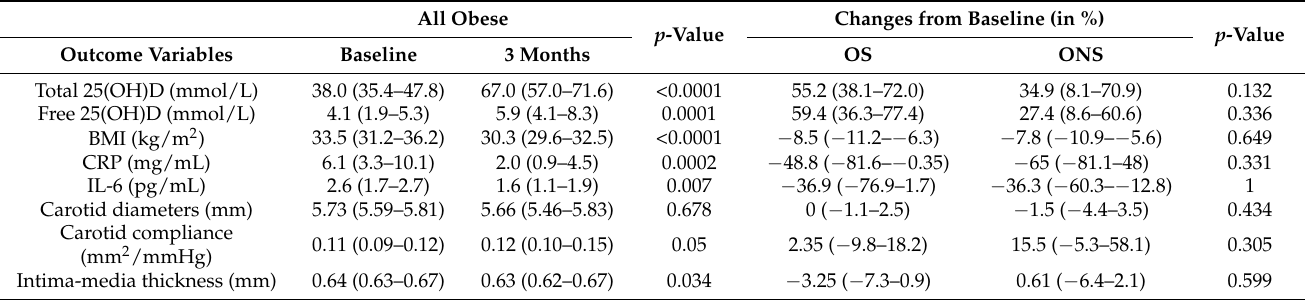
Table 2. Changes in biological and vascular outcomes at three months.